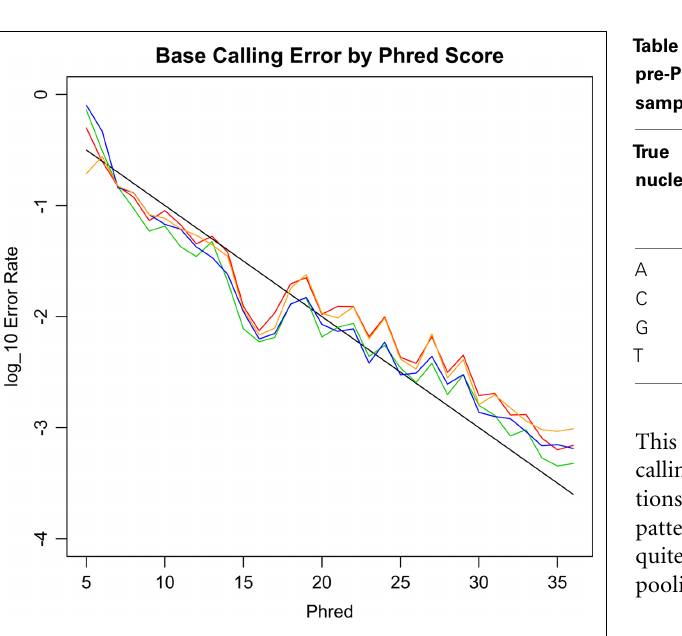
position of nucleotide on the mitochondrial genome (16,568kb) and the y axis stands for the fold coverage for each nucleotide position.